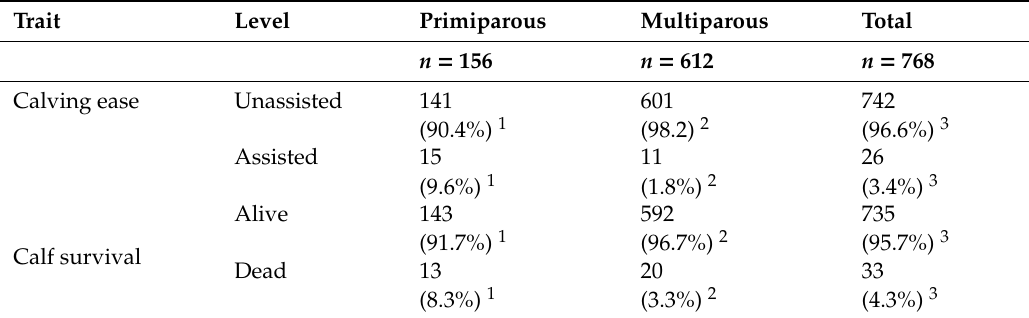
Table 3. Absolute and relative frequencies for calving ease and calf survival in relation to parity of the dam.